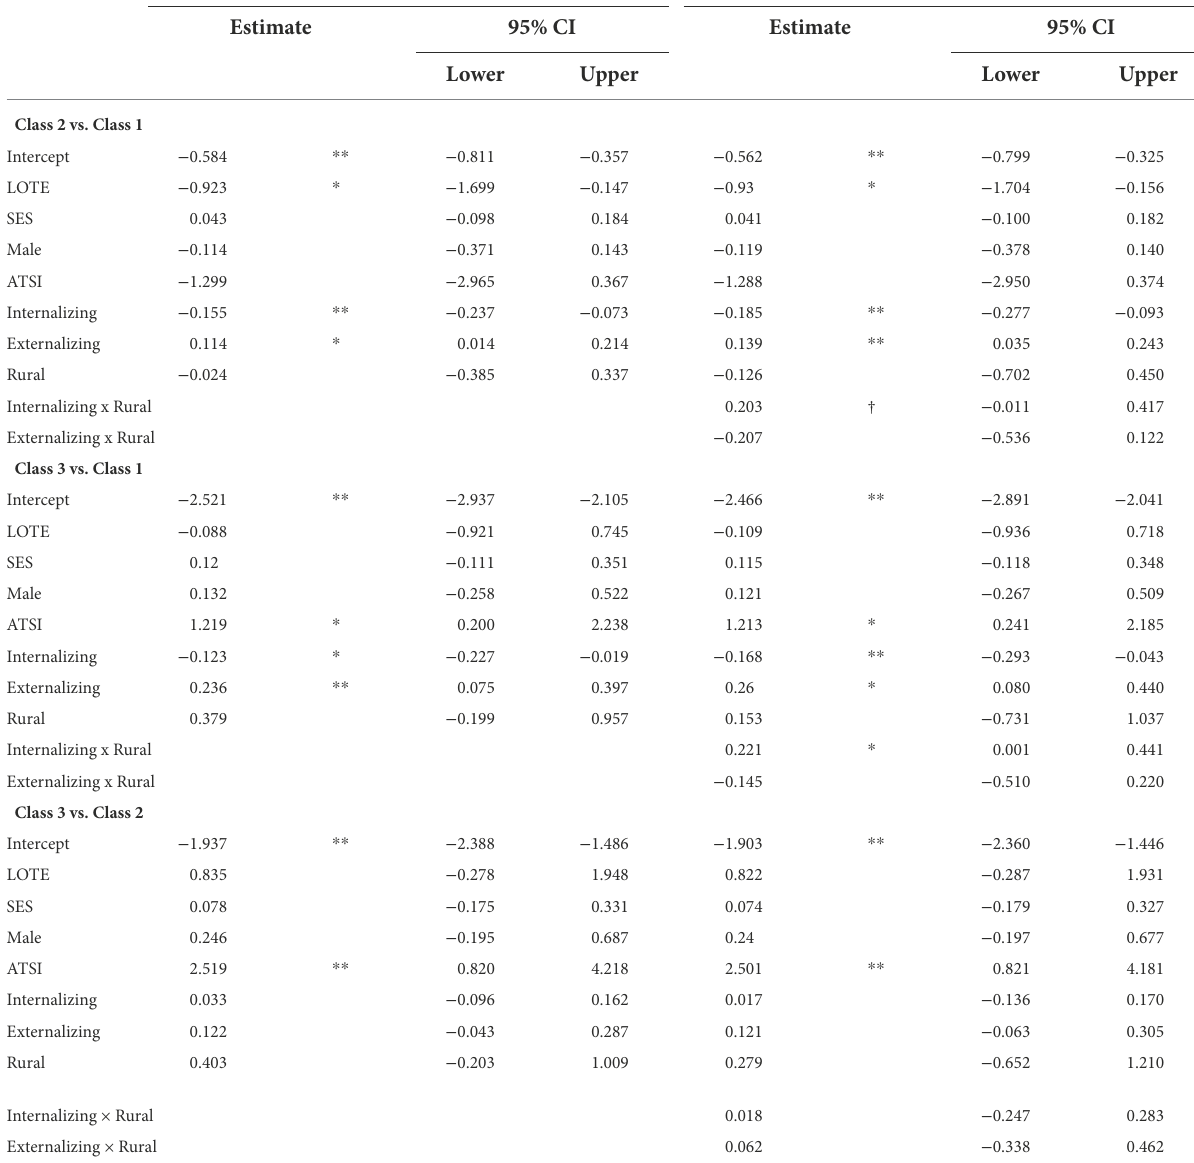
TABLE 3 Logistic regression parameters predicting class